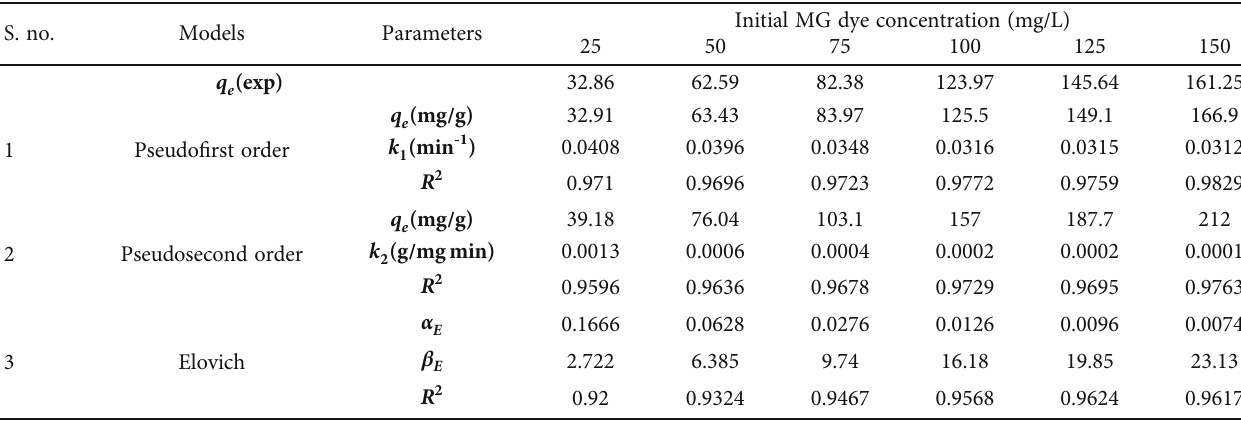
Table 3: Kinetics parameters for MG dye adsorption onto